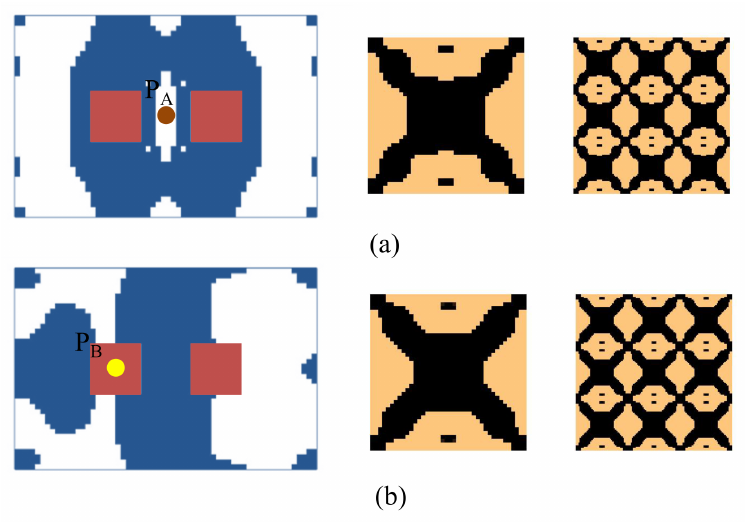
Figure 27. Design results the composite plate with four corners fixed shown in Figure 19. ( a , b ) correspond to the excitation points P A and P B , respectively. The excitation frequency is 0–50 Hz.